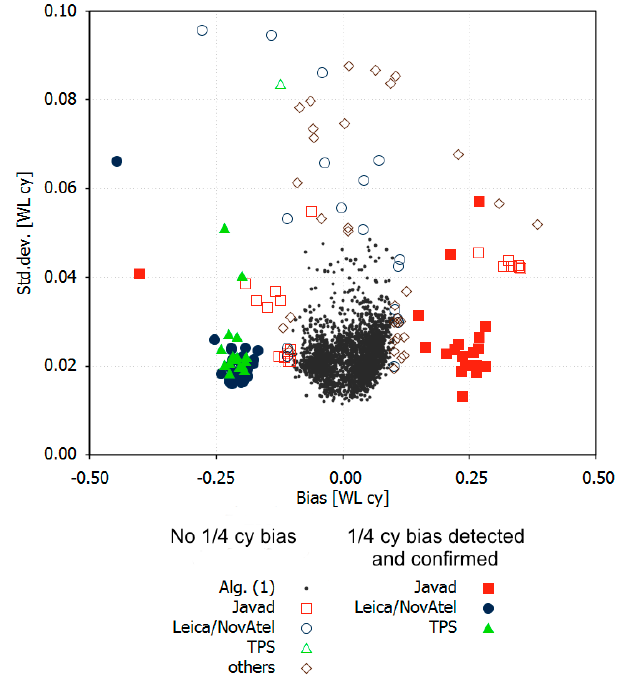
Figure 4. Estimated L2 biases between non-L2C and L2C measurements according to algorithm 1, validations (filled symbols) or rejections (open symbols) by Algorithms 2 or 3.